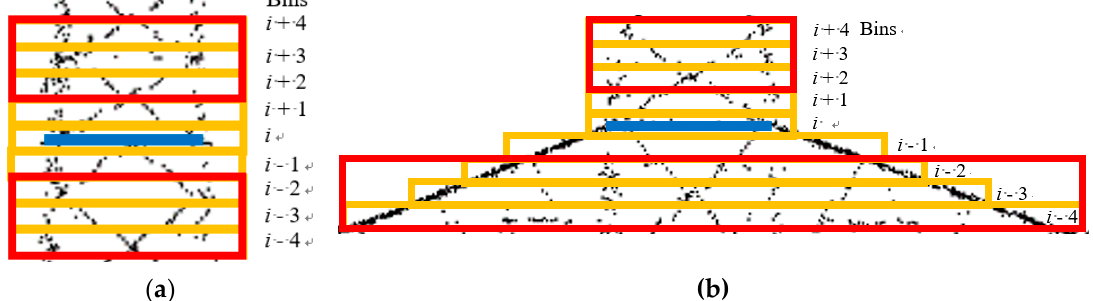
Figure 10. The relation between the segmentation positions with the boundaries of complex structures.